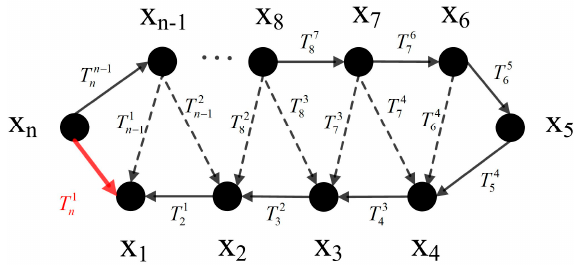
Figure 5. Topology of the graph optimization for one segment.